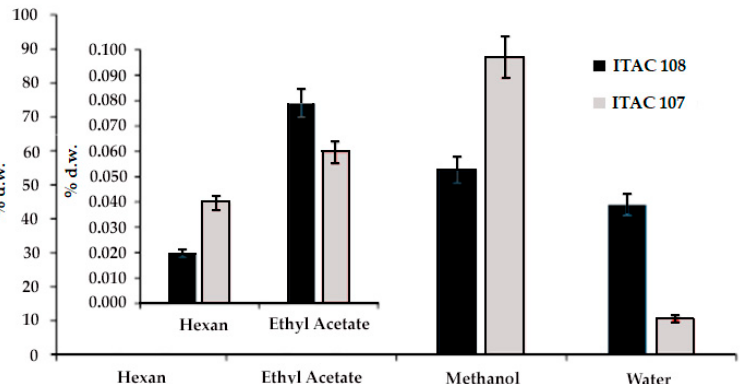
Figure 1. Fractionated extraction yield (expressed as % dry weight) of Cyanobium sp. ITAC108 and Synechococcus sp. ITAC107 biomass. Different solvents with different polarity indexes (hexane, ethyl acetate, methanol and water) were used.